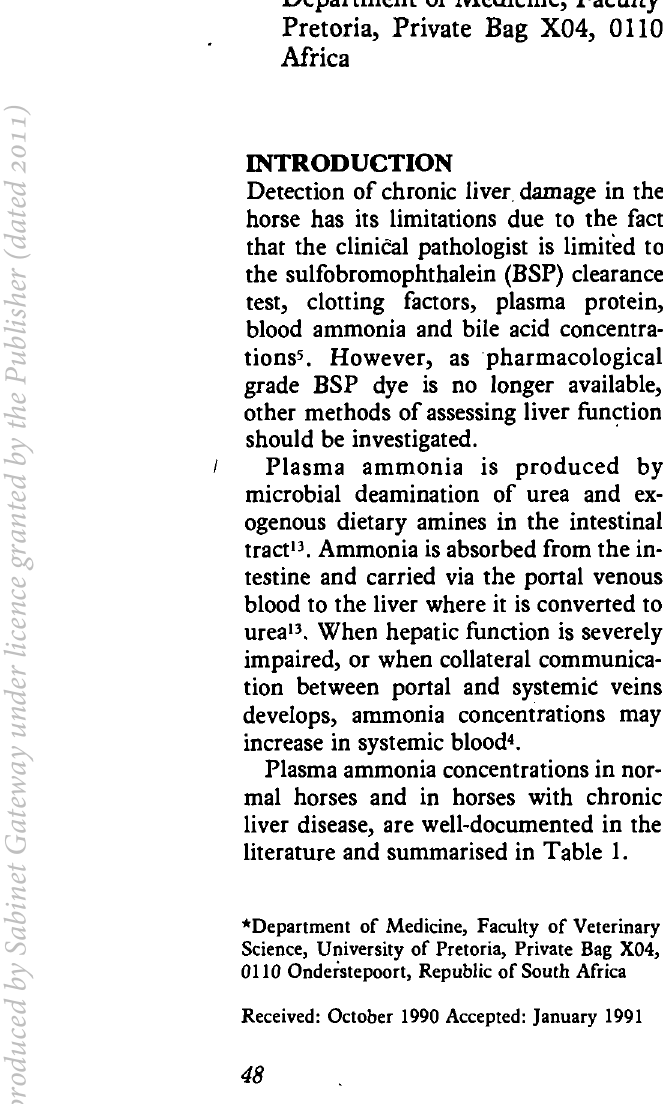
Table I: Reference values for plasma ammonia concentrations in